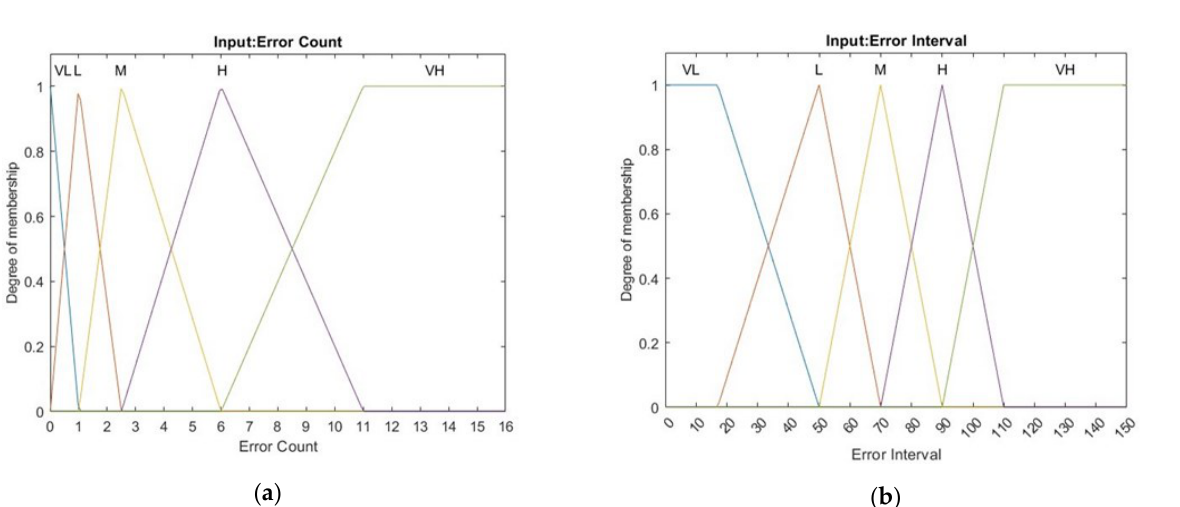
Figure 6. Membership functions for antecedent parts: ( a ) error count and ( b ) error interval.